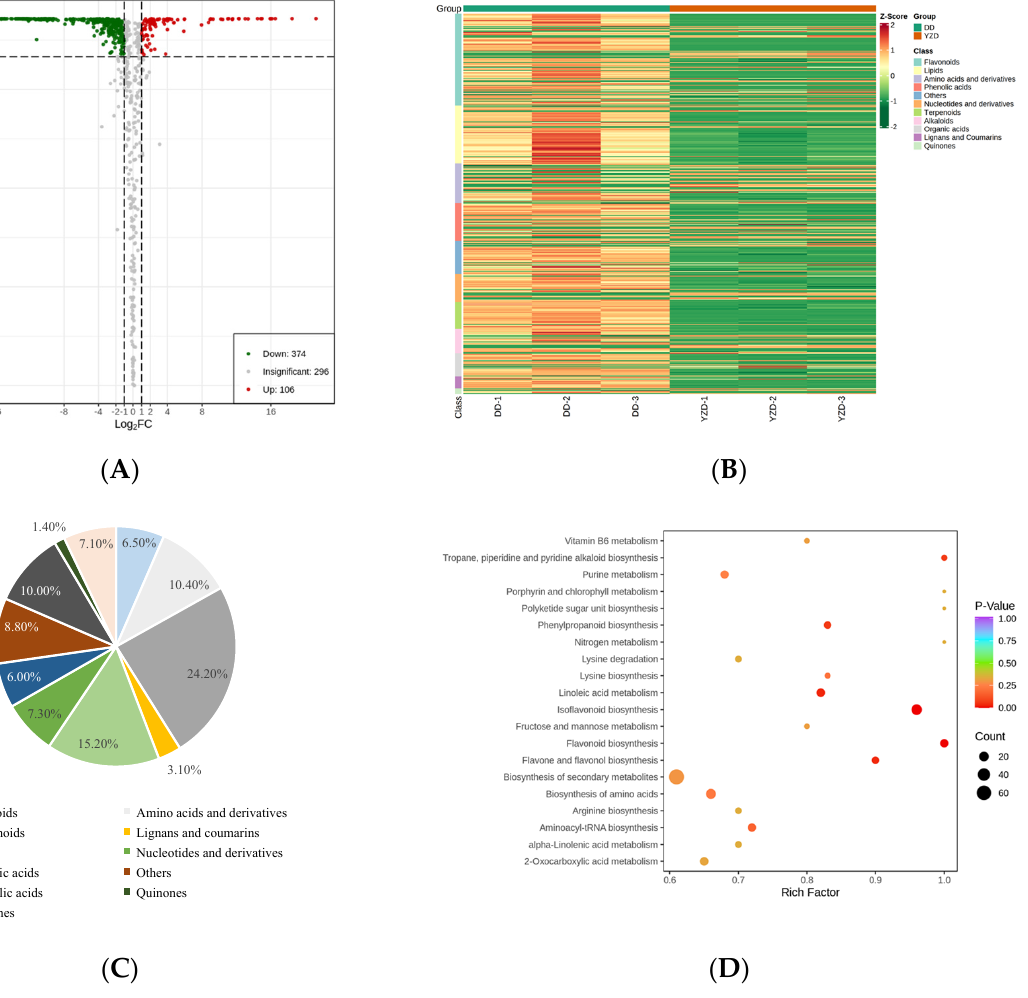
Figure 6. Analysis of DAMs between YZD and DD. ( A ) Volcano plot of the DAMs. ( B ) Heatmap of the DAMs. ( C ) Types and proportions of the DAMs. ( D ) Enrichment of KEGG pathways of DAMs. Through analysis, we got the differences of primary metabolites and the differences of secondary metabolites in YZD and DD (Table S3). For primary metabolites, 42 metabolites were up-regulated and 146 metabolites were down-regulated in YZD compared with